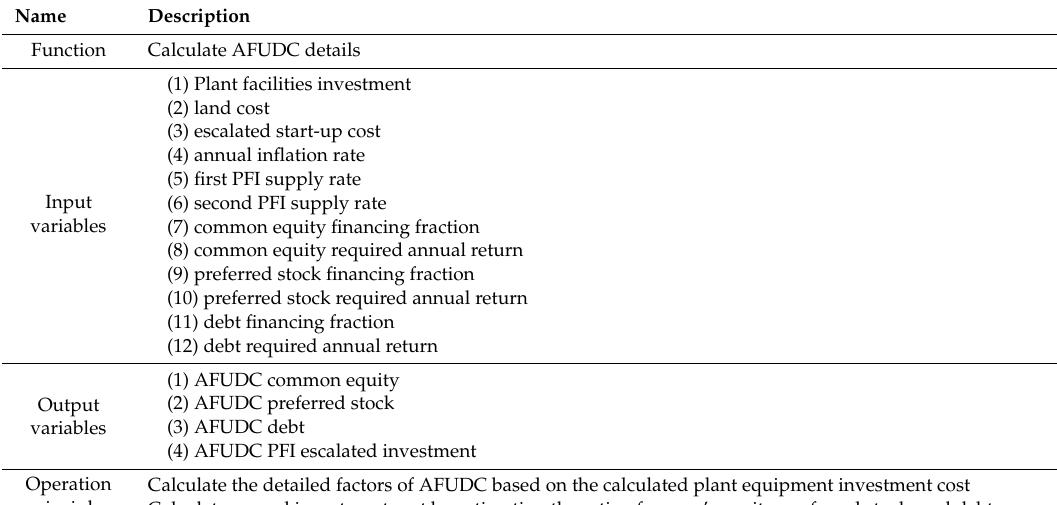
Table 6. Implementation example of TCI estimation